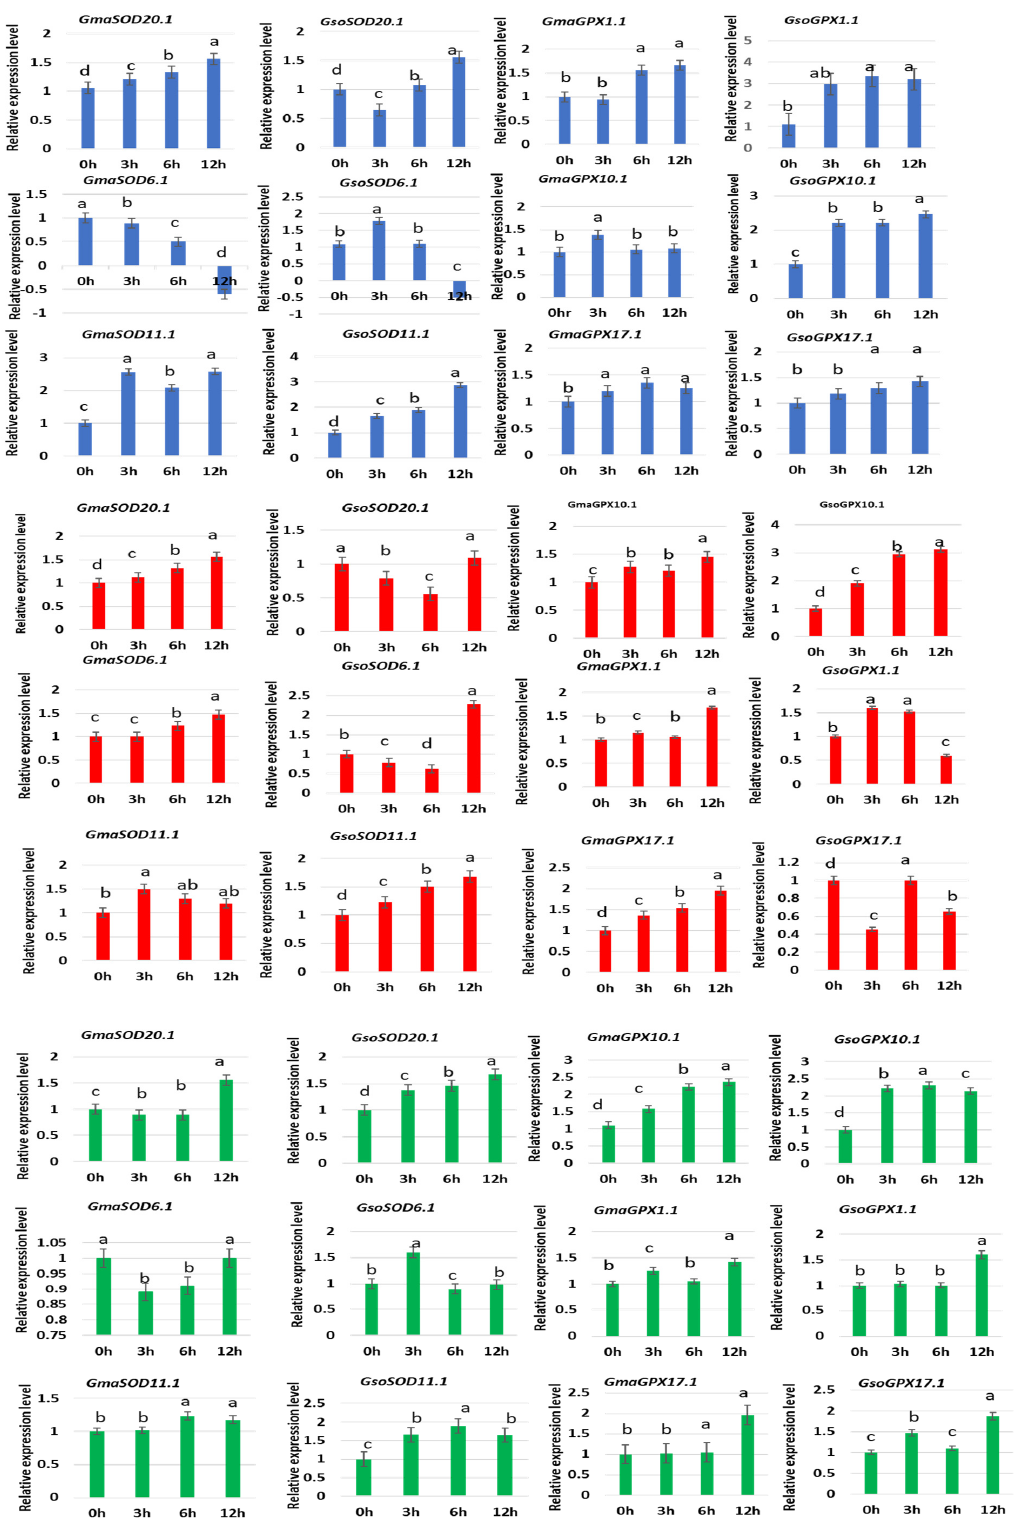
Figure 10. Expression of different selected SOD and GPX genes of G. soja under different stresses viz H 2 O 2 (blue color), NaCl (red color) and PEG (green color). Data represent mean and standard deviation of three repeats ( n = 3). Data with the same letters in lowercase (a, b, c and d) above bars indicate no significant differences at the 0.05 level at different time intervals in the soybean genotype according to the Duncan’s multiple range